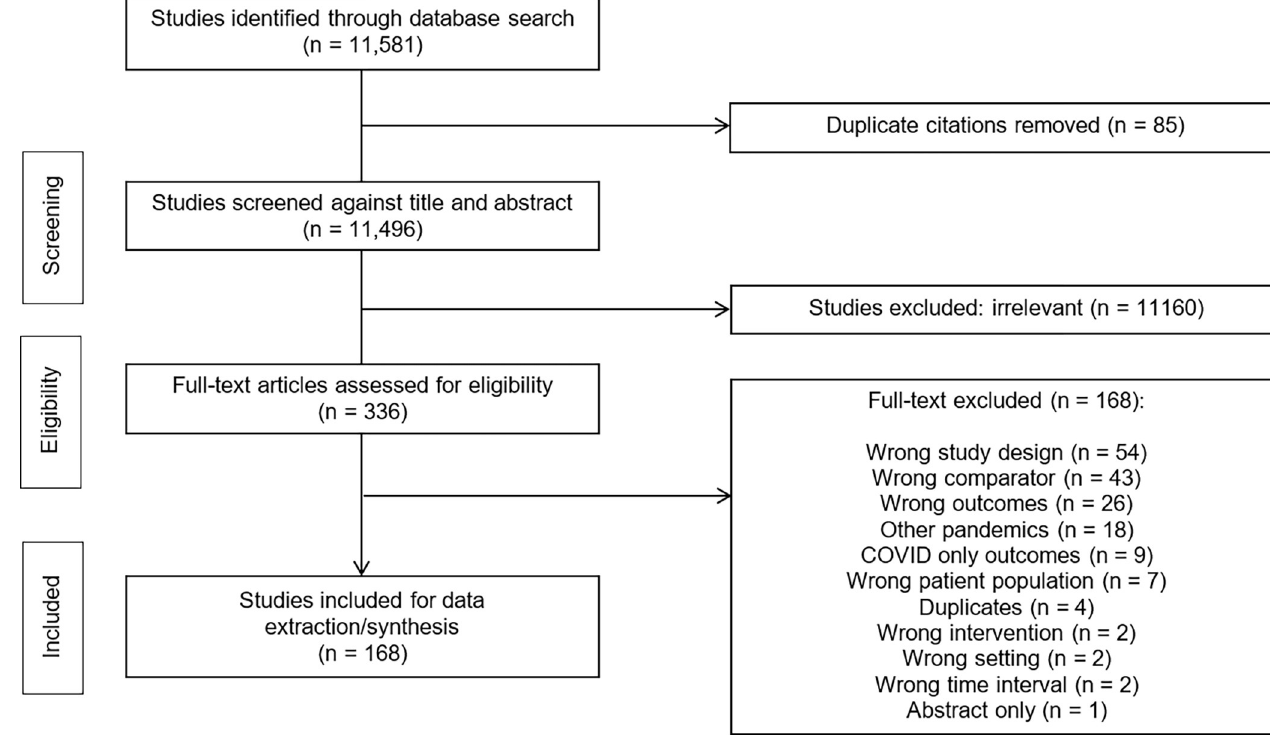
Fig 1. COPES PRISMA flow diagram (non-COVID